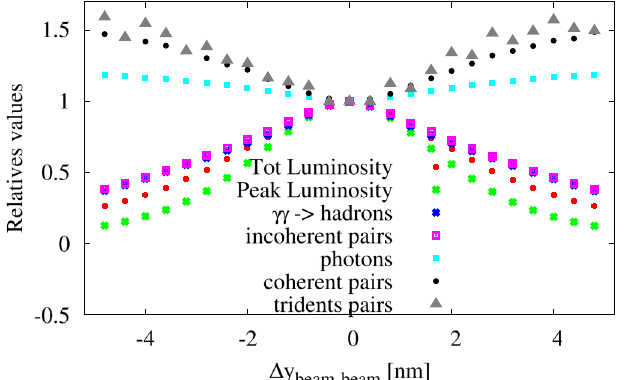
FIG. 14. Dependence of various relative yields on vertical offset between colliding bunches normalized to production at perfect conditions. The average strong field increases with this offset, increasing the yield of strong field processes. Peak luminosity refers to the amount of luminosity within 1% of the nominal collision energy. γγ → hadrons refers to the amount of hadronic events from collisions between real or virtual